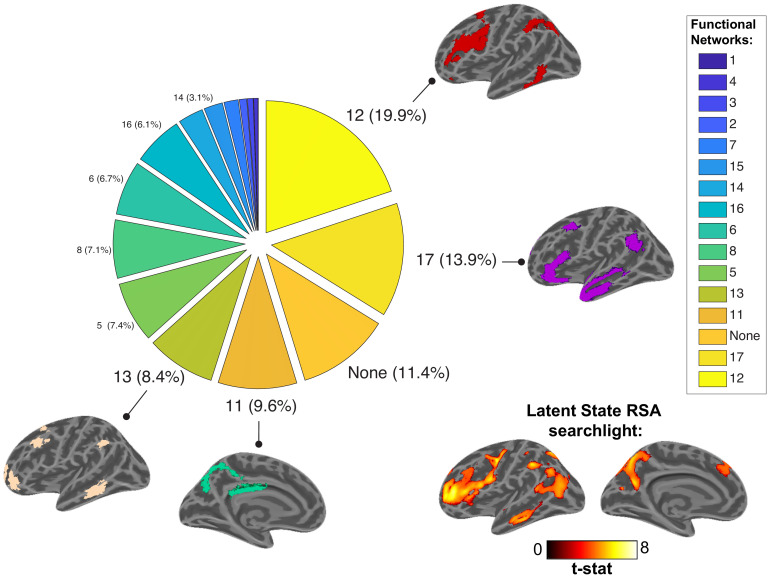
Percentage overlap of latent state (LS) statistical map from Figure 5a with 17 network parcellation of functional connectivity networks from Yeo et al., 2011 based on the data of 1000 participants.Numbers correspond to network identifications from the same study with percentage of voxels within each network shown in parentheses and represented by the pie chart. Surface renderings of the three networks that included the largest proportion of voxels are shown on an inflated cortical surface. Bottom right-hand corner shows the t-statistic map for the LS regressor from the representational similarity analysis searchlight for comparison, also shown in Figure 5a.